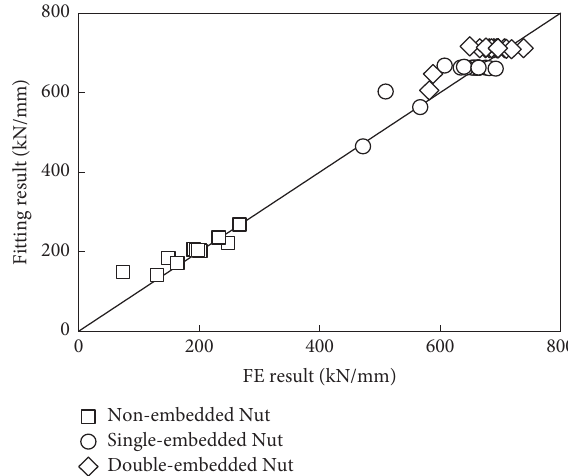
Figure 9: Comparisons of coupling stiffness between the FE results and fitting results.